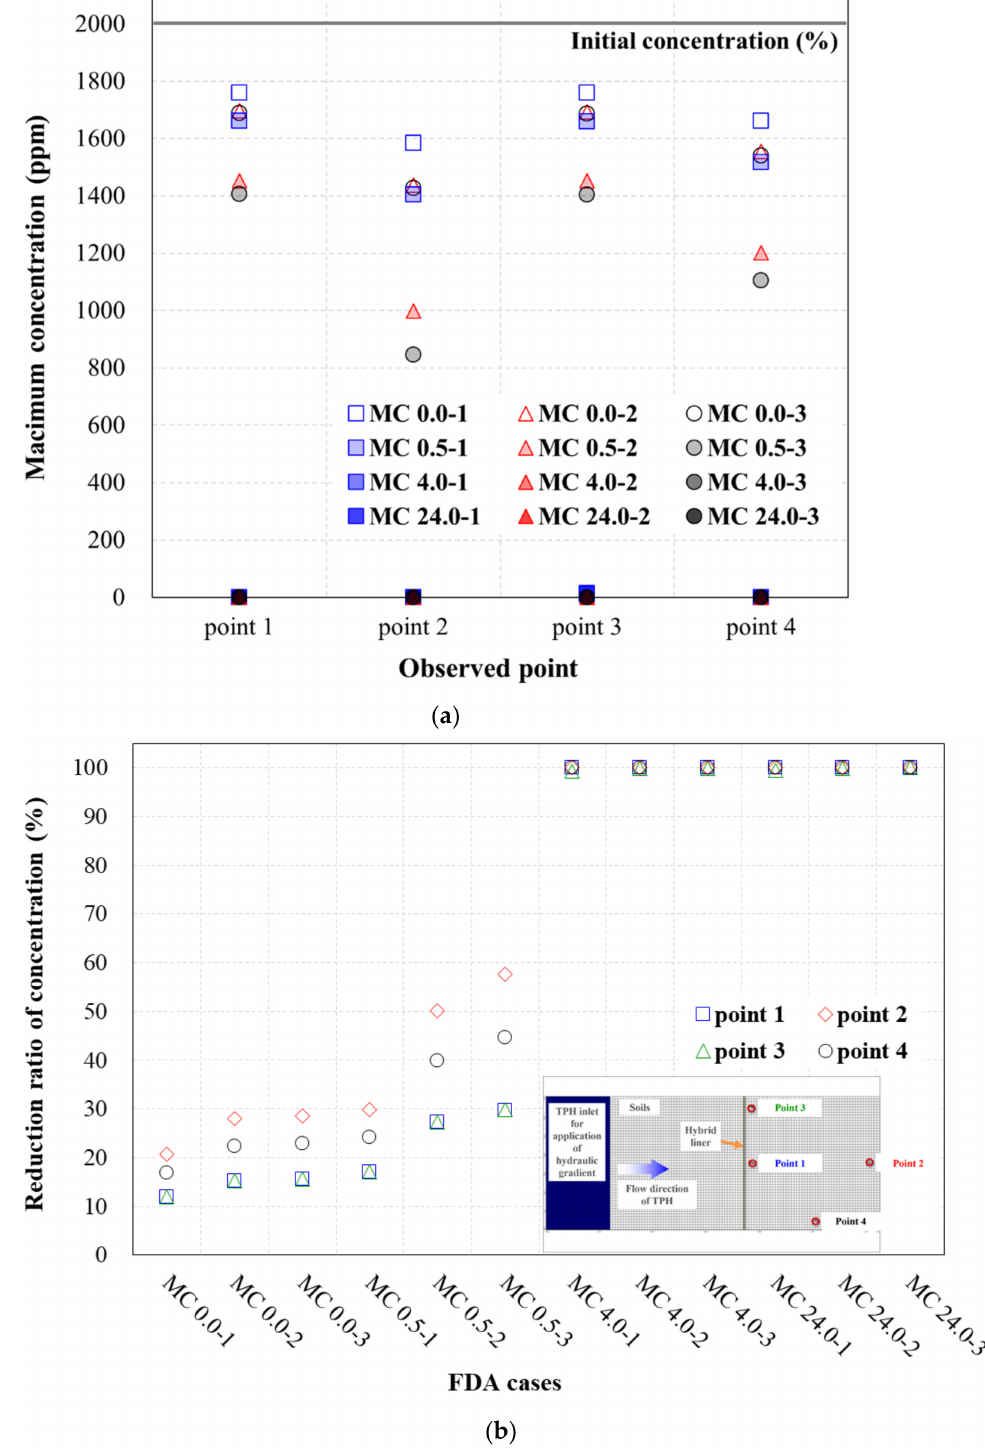
Figure 7. Concentration variance at the medium-TPH condition: ( a ) Maximum concentration (ppm) at the observation point; ( b ) Reduction ratio of the concentration at the observation